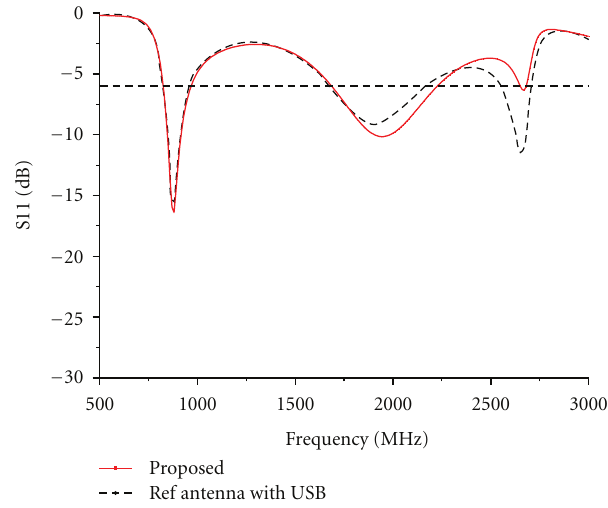
Figure 7: Comparison of reflection coe ffi cient between the antenna with and without USB